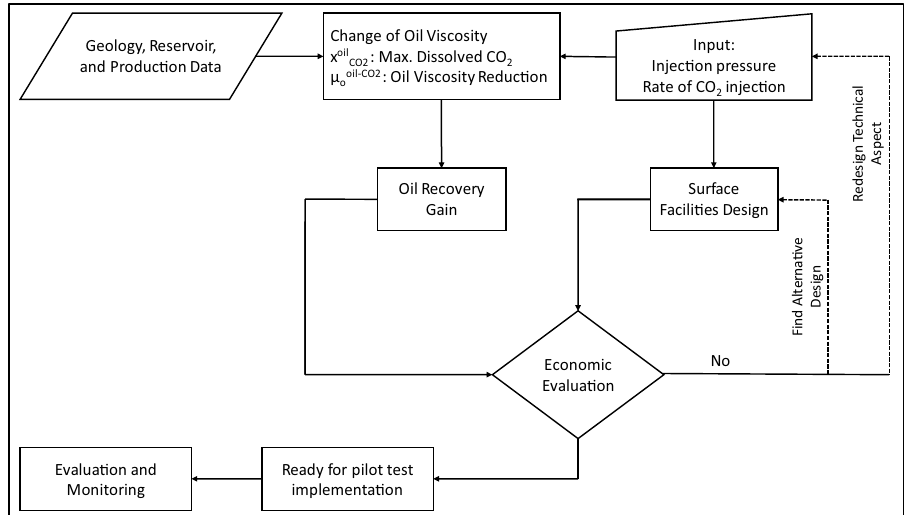
Fig. 1 Flowchart of CO 2 -EOR study Geology, Reservoir, and Produc(cid:31)on Data